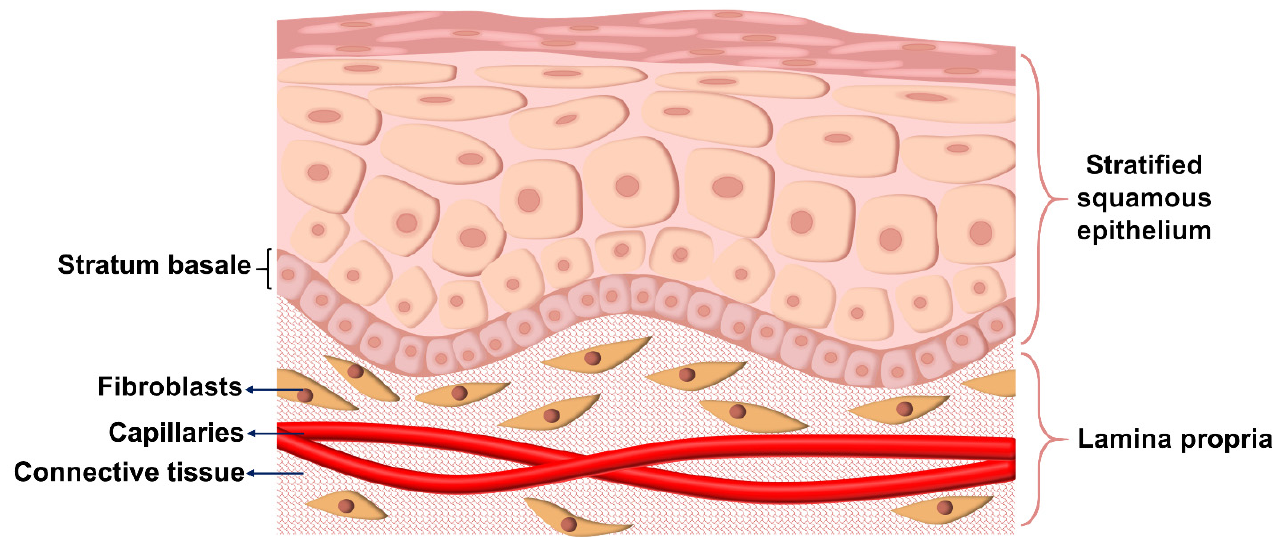
Figure 3. Schematic diagram of the organization of the oral mucosa. In different regions of the oral cavity, the cells of the oral mucosal epithelium are differentiated between keratinocytes and non-keratinocytes. The keratinized epithelium is distributed on the gingival and dorsal surface of the tongue. The keratinized squamous epithelium is mainly divided into four layers: basal layer, echinoderm layer, granular layer, and stratum corneum. The basal layer is the innermost layer of the epithelium. Basal cells are formed by the division of stem cells. In addition, a portion of stem cells will divide and differentiate into epithelial cells to maintain the dynamic balance of proliferation and shedding of mucosa cells. The echinoderm layer is located outside the basal layer and developed from the proliferating basal cells. The protrusions between the cytoplasm